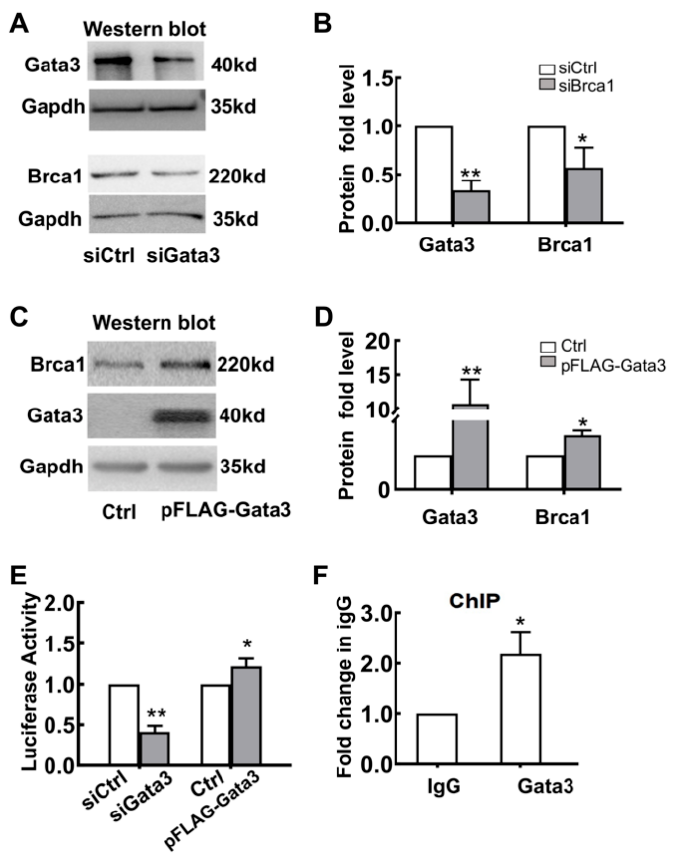
Figure 4. Brca1 is transcriptionally regulated by Gata3 . ( A ) Brca1 expression decreased in the Gata3 - silenced 661W cells, as evidenced by Western blot. ( B ) The relative protein expression levels of Gata3 and Brca1 are presented as histograms. ( C ) Exogenous Gata3 significantly increased Brca1 expression in 661W cells. ( D ) The relative protein expression levels of Gata3 and Brca1 are presented as histograms. ( E ) The luciferase activity of the Brca1 promoter decreased with the downregulation of Gata3 but increased with the upregulation of Gata3 in 661W cells. ( F ) Gata3 might bind to the Brca1 promoter and regulate its activity, as evidenced by ChIP assays. The asterisks indicate statistically significant differences (* p < 0.05, ** p < 0.01).